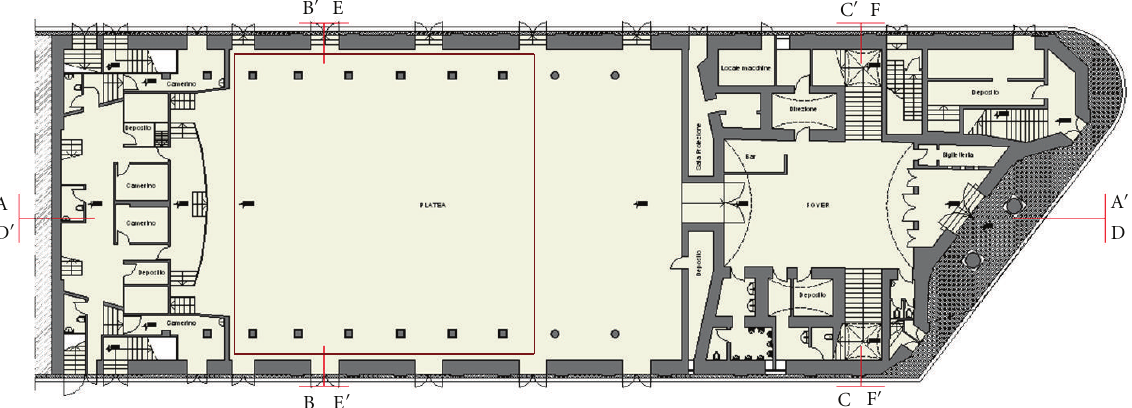
Figure 8: The specification of the location of the investigation